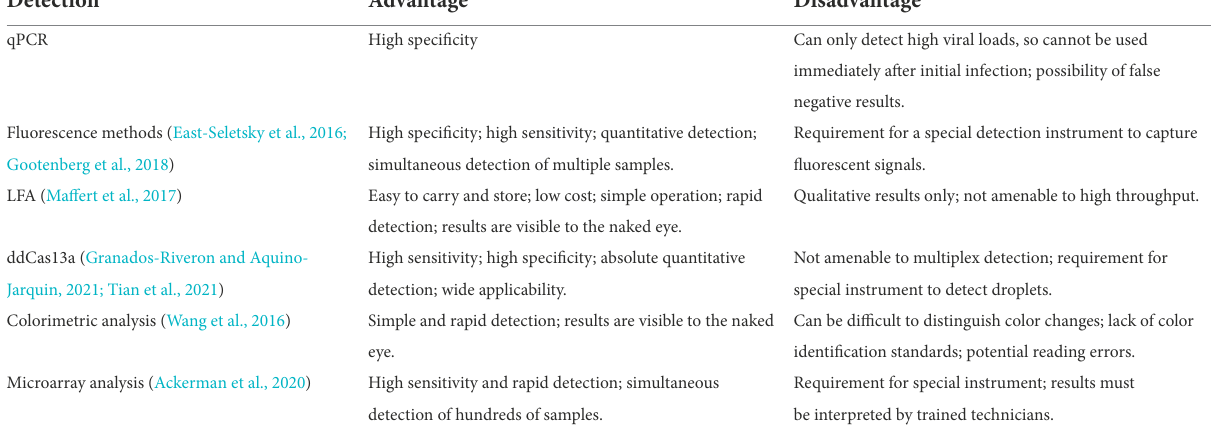
TABLE 4 Advantages and disadvantages of amplification product detection